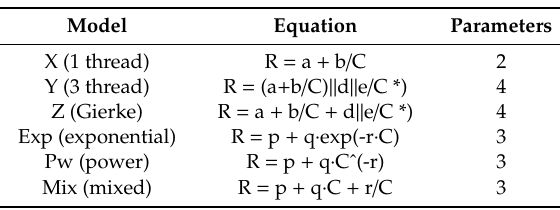
Figure 4. The models X (one thread), Y (three thread), and Z (Gierke). Table 2. Used